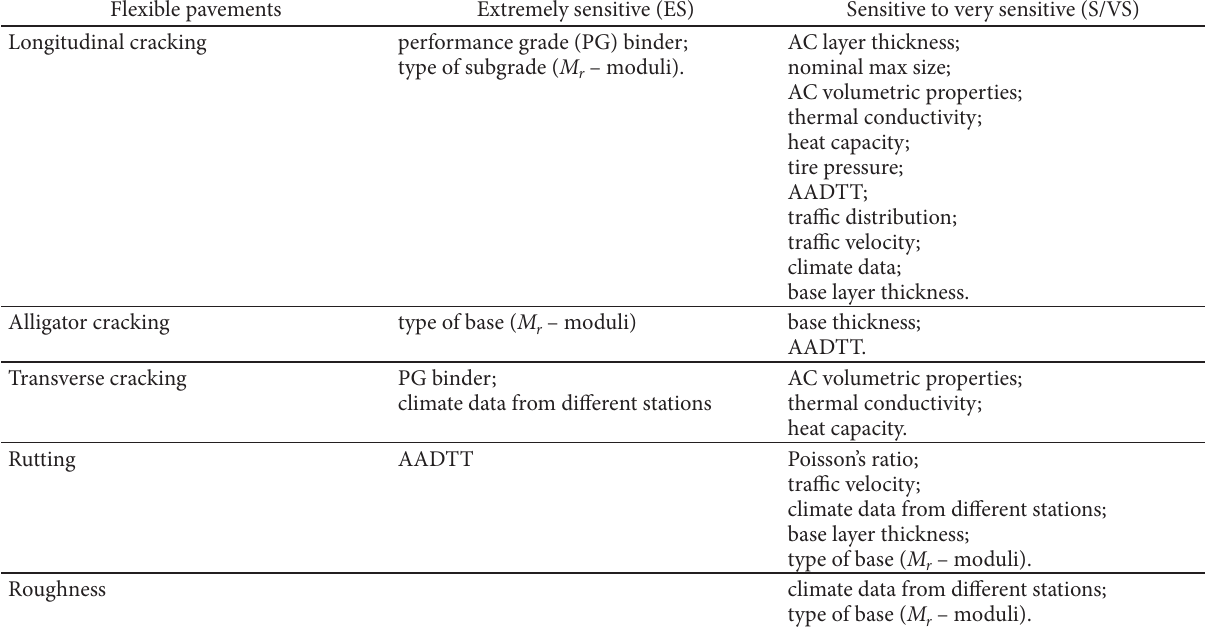
Table 3. Input factors of significant sensitivity (flexible pavements) Flexible